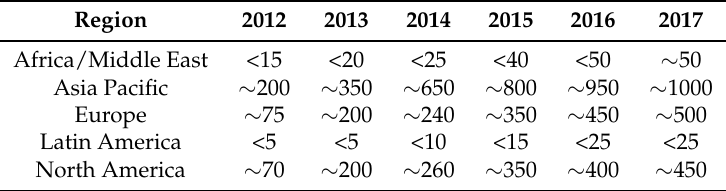
Table 1. Sales of charging stations (thousands), 2012–2017.